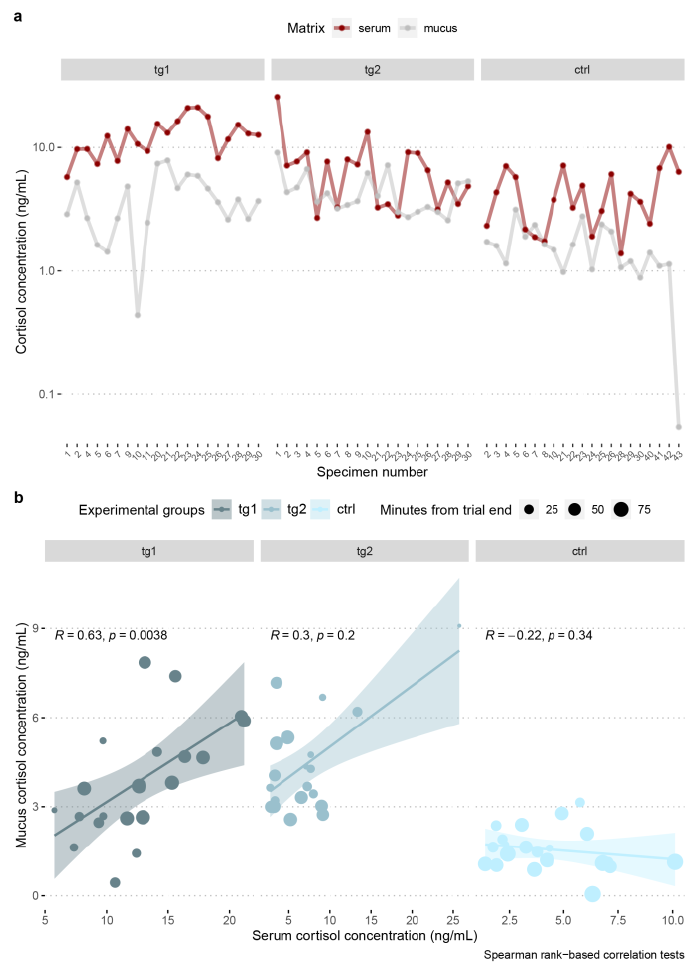
Figure 5. Comparison of O. mykiss blood serum – skin mucus cortisol concentrations ( a ), and correlation tests between matrices ( b ) per experimental group, with indication of the time, in minutes, elapsed from the end of trial to sampling operations, and details of the statistical tests. Colors indicate experimental groups. Table 3 . Statistical details of the correlation tests between cortisol concentrations measured in blood serum and skin mucus. r: correlation coefficient.